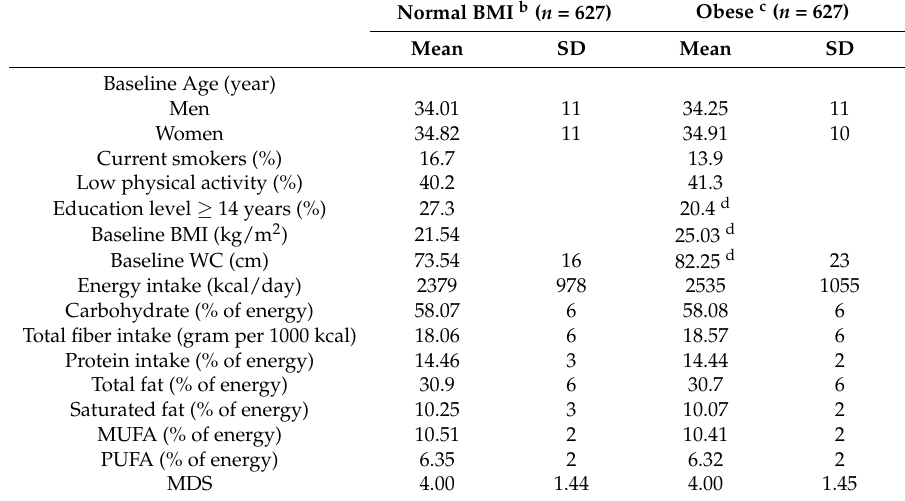
Table 1. Characteristics of the study population in cases and controls a (Tehran Lipid and Glucose Study).